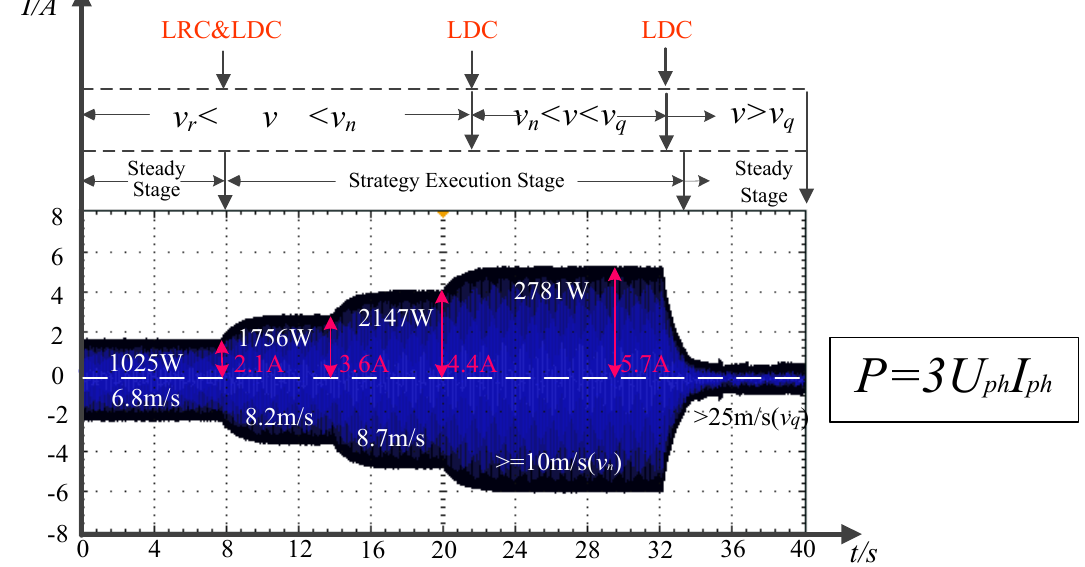
Figure 10. Generation of WTSS in Scenario II.